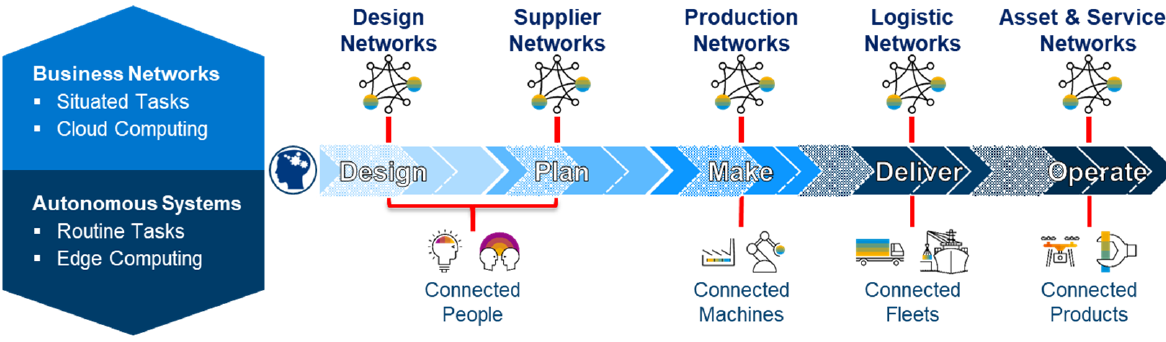
Figure 5. The digital enterprise (own illustration).